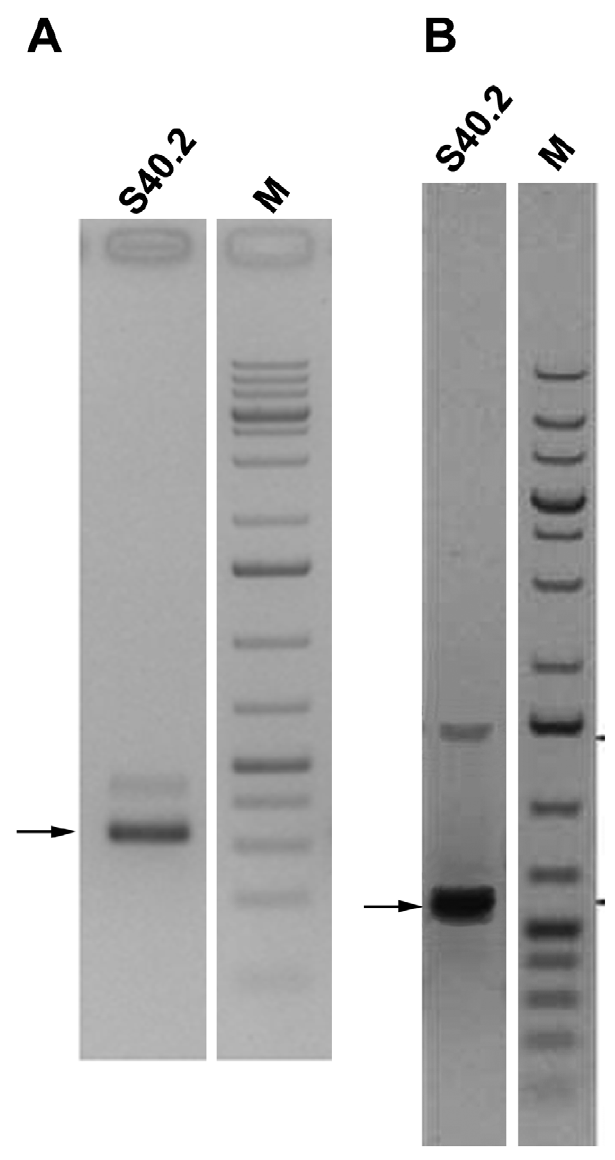
Figure 8. Cloning of fusion transcripts PUM1-FUS-19q-I and PUM1-FUS-19q-II. Fusion transcripts resulting from the t(1;19) in cell line S40.2 were detected by RT-PCR and analyzed by gel electropho- resis. M= Marker DNA (1 kb + , Fermentas). S40.2= Thyroid adenoma cell line S40.2. The arrows point to the corresponding bands that were excised. Isolated DNA was sequenced and analyzed. Weak bands above may represent splice variants. A ) Transcript PUM1-FUS-19q-I generated with primers Ex9_up and 19_2. B ) Transcript PUM1-FUS-19q-II generated with primers Ex9_up and 500_Cluster_polyA_I.